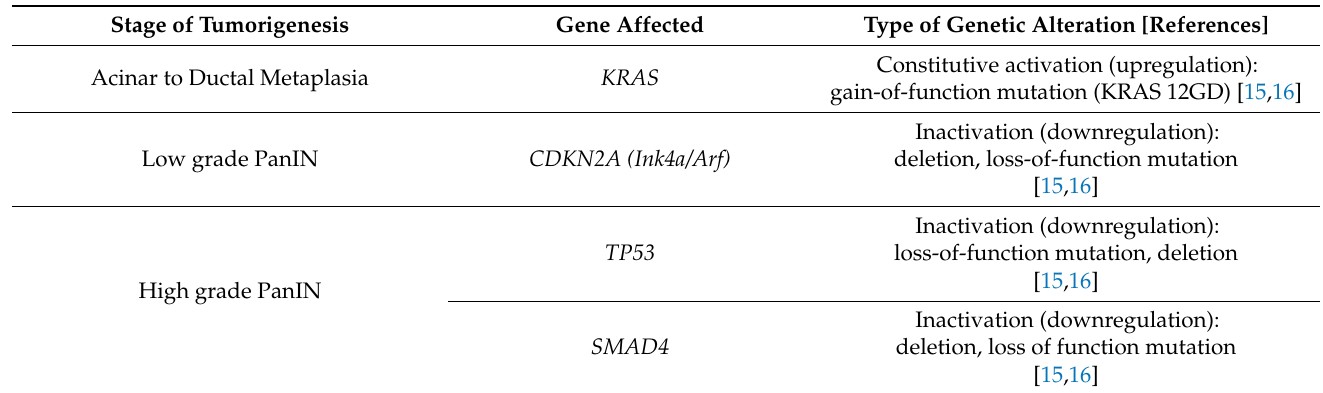
Table 1. Signature genetic alterations in each step of the PDAC tumorigenesis